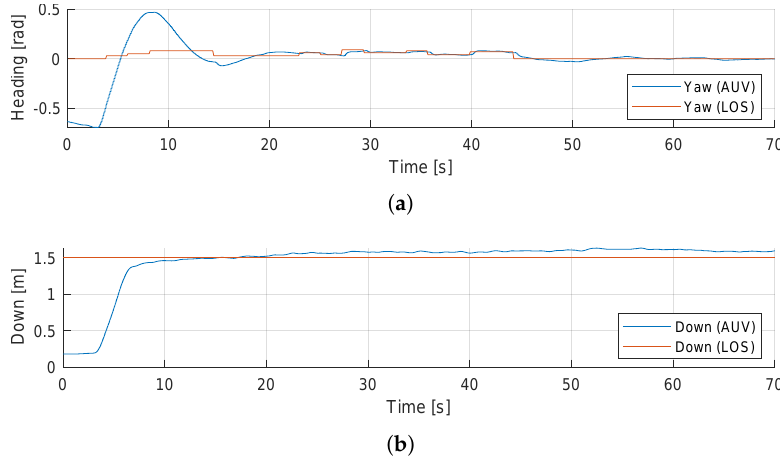
Figure 16. AUV Control scenario: ( a ) Comparison of heading angle from the LOS guidance system with field-test data. ( b ) Comparison of the constant depth of 1.5 m with field-test data.